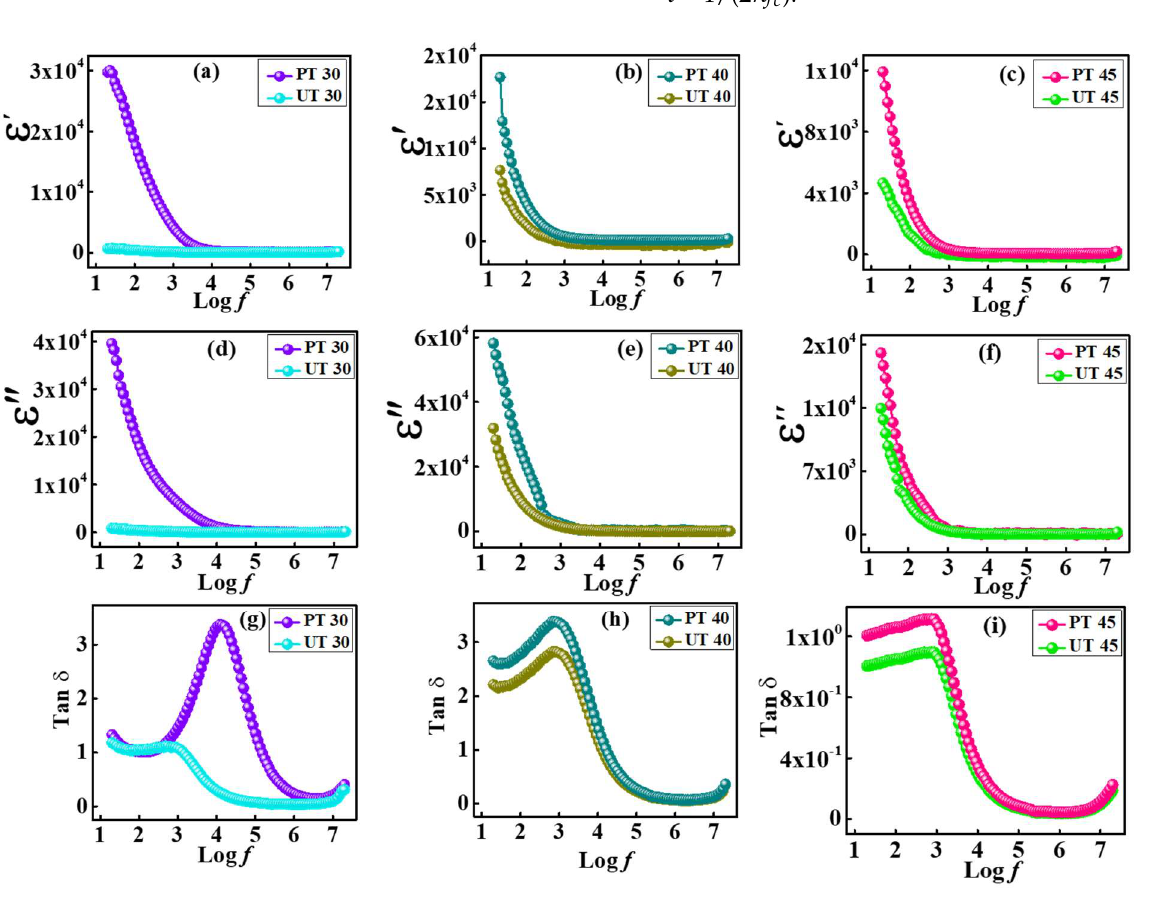
Figure 8. Comparison study of variation in (a − c) real permittivity, (d − f) imaginary permittivity, and ( g – i ) tangent loss for plasma-treated and untreated samples. ( g – i ) tangent loss for plasma-treated and untreated